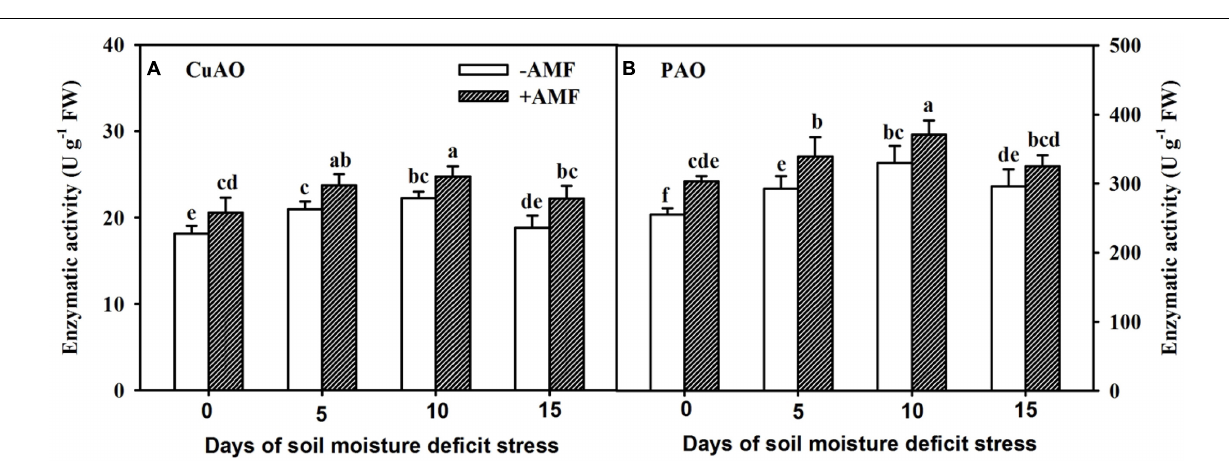
FIGURE 7 | Activities of root copper-containing diamine oxidase (CuAO) (A) and FAD-containing polyamine oxidase (PAO) (B) of trifoliate orange seedlings inoculated with and without Funneliformis mosseae during exposure to soil moisture deficit stress (SMDS) of 0-15 days. Data (mean ± SD, n = 4) followed by different letters above the bars indicate significant ( P < 0.05)